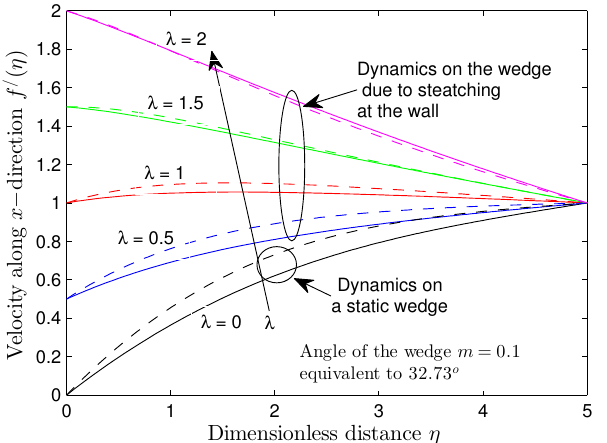
Figure 3. Effect of wall stretching velocity λ on the dynamics of both ternary hybrid nanofluids along x − direction when m =